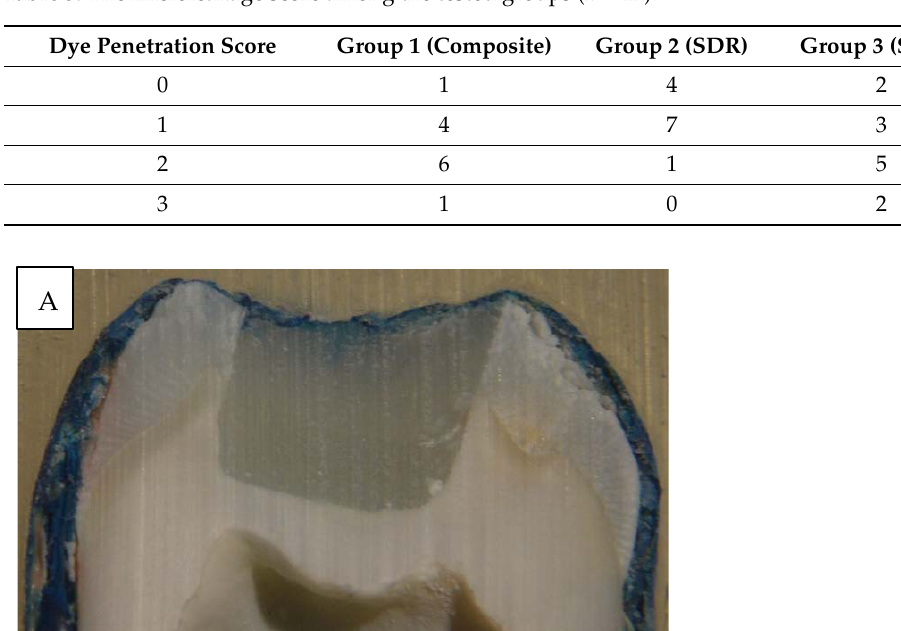
Figure 3. Pictures ( A – C ) of the sectioned specimen after dye penetration analysis. Picture A showed minimal to no marginal staining, while the other pictures show moderate (Picture B ) to deep (Picture C ) penetration of the dye, starting from the margins. In terms of gap formation values at the bonding interface, layered composite filling (Group 1) produced significantly higher gap formation compared to the bulk-fill groups (Group 2, p = 0.000, Group 3, p = 0.000) (Figure 4). Therefore, the third null hypothesis was also rejected. Again, the two bulk-fill groups (Group 2 and 3) did not differ in gap for- mation along from each other along the restoration-cavity interface.